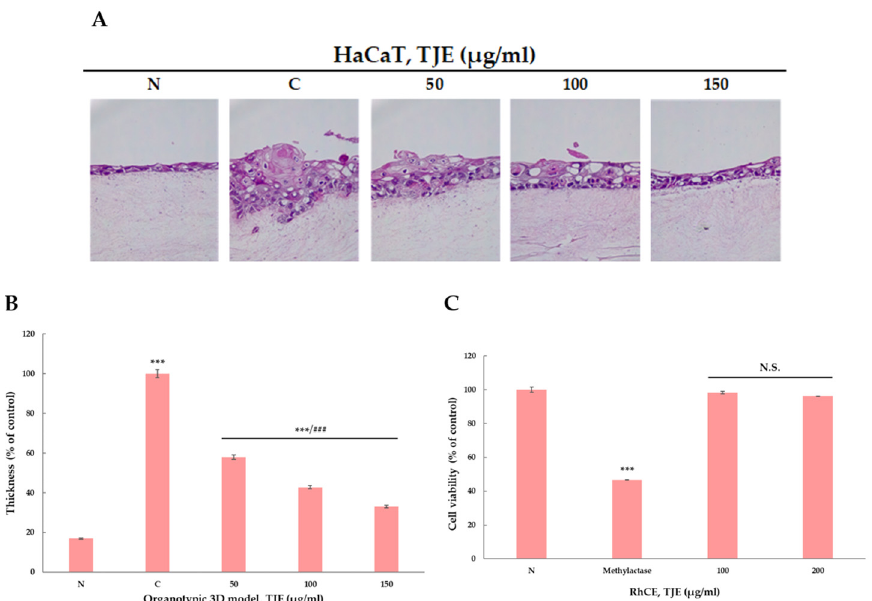
Figure 6. ( A ) The organotypic three-dimensional models using HaCaT keratinocytes and dermal fibroblasts were stained for H&E as red and pink areas and represented by a microscope (Carl Zeiss, USA). The photographs were taken at a magnification of ×200. ( B ) Measurement of the keratin layer. The layer was counted from randomly selected fields of each section using the ImageJ program. ( C ) In vitro RhCE assay (eye irritation test) was tested for TJE (100 μ g/mL and 200 μ g/mL) using the OCL 200 EIT. Methylactase was used as positive control. The statistical analysis of the data was carried out by use of a t -test. *** ,### p < 0.001 (each experiment, n = 3). N.S.: not significant. N: negative control, C: positive control (only TNF- α (10 ng/mL) and IFN- γ (10 ng/mL) treated